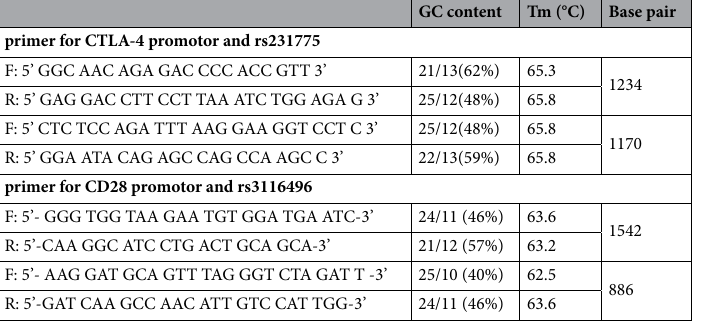
Table 5. Primers used for amplifying the target region of CTLA4 and CD28. F forward primer, R reverse